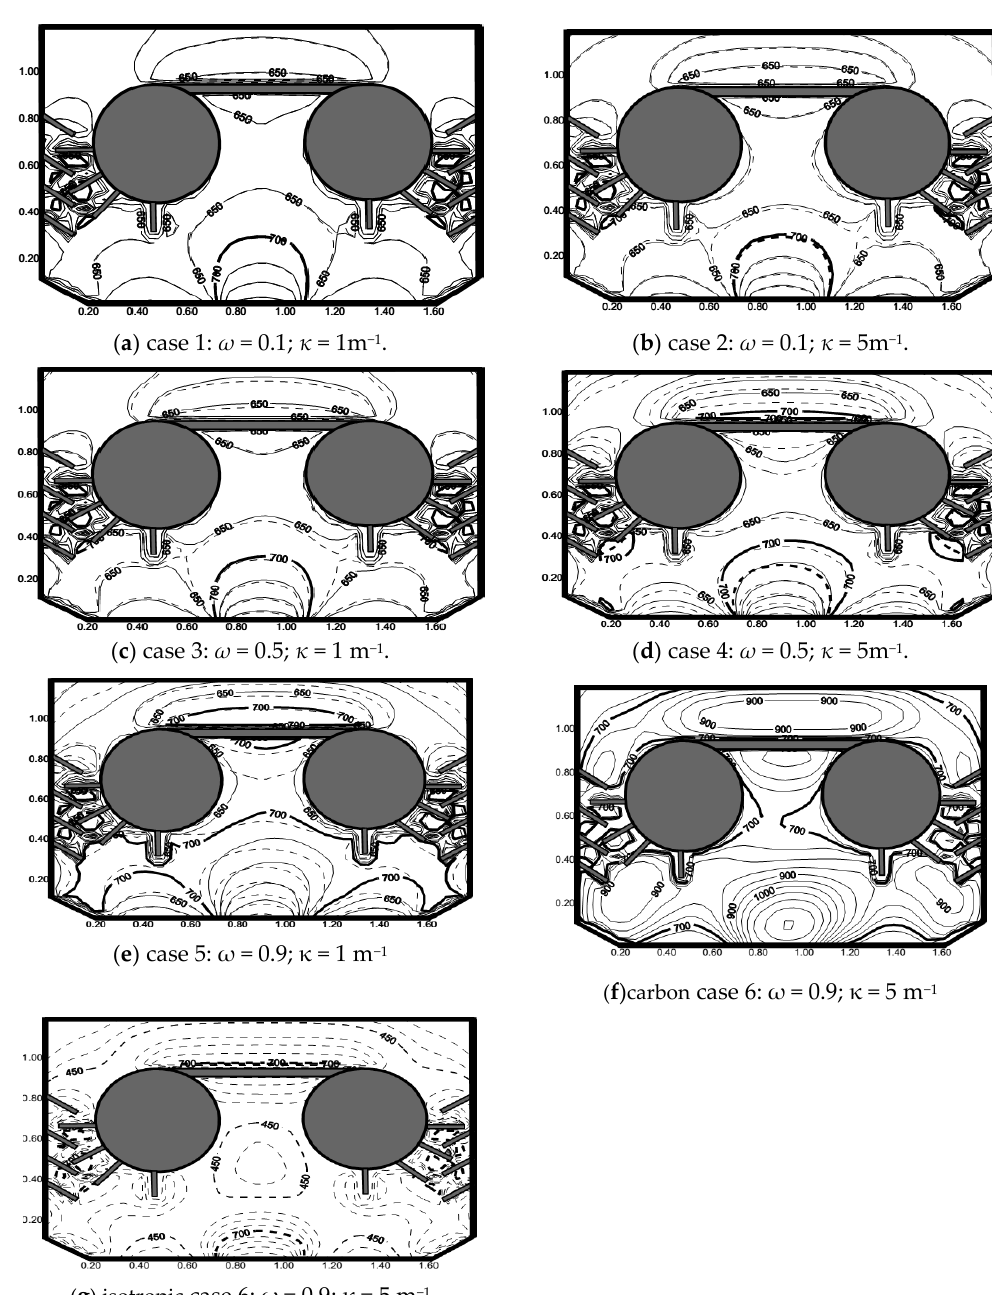
Figure 5. Effects of the absorption and albedo coefficients on the medium temperature pattern: Comparison between the isotropic case and carbon. Dashed lines: Isotropic, continuous lines: carbon.